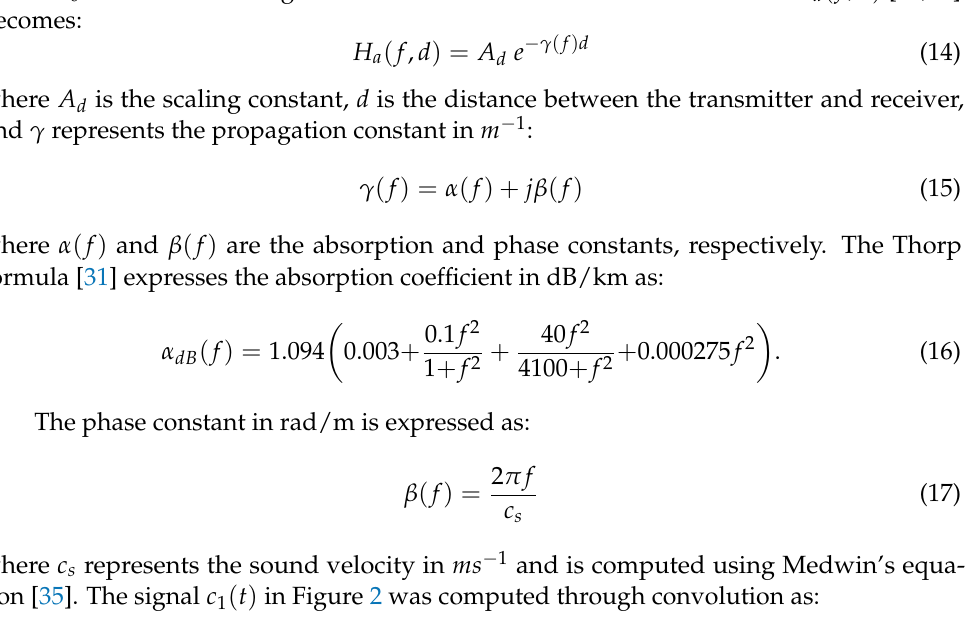
Figure 2. Shallow underwater acoustic channel model.